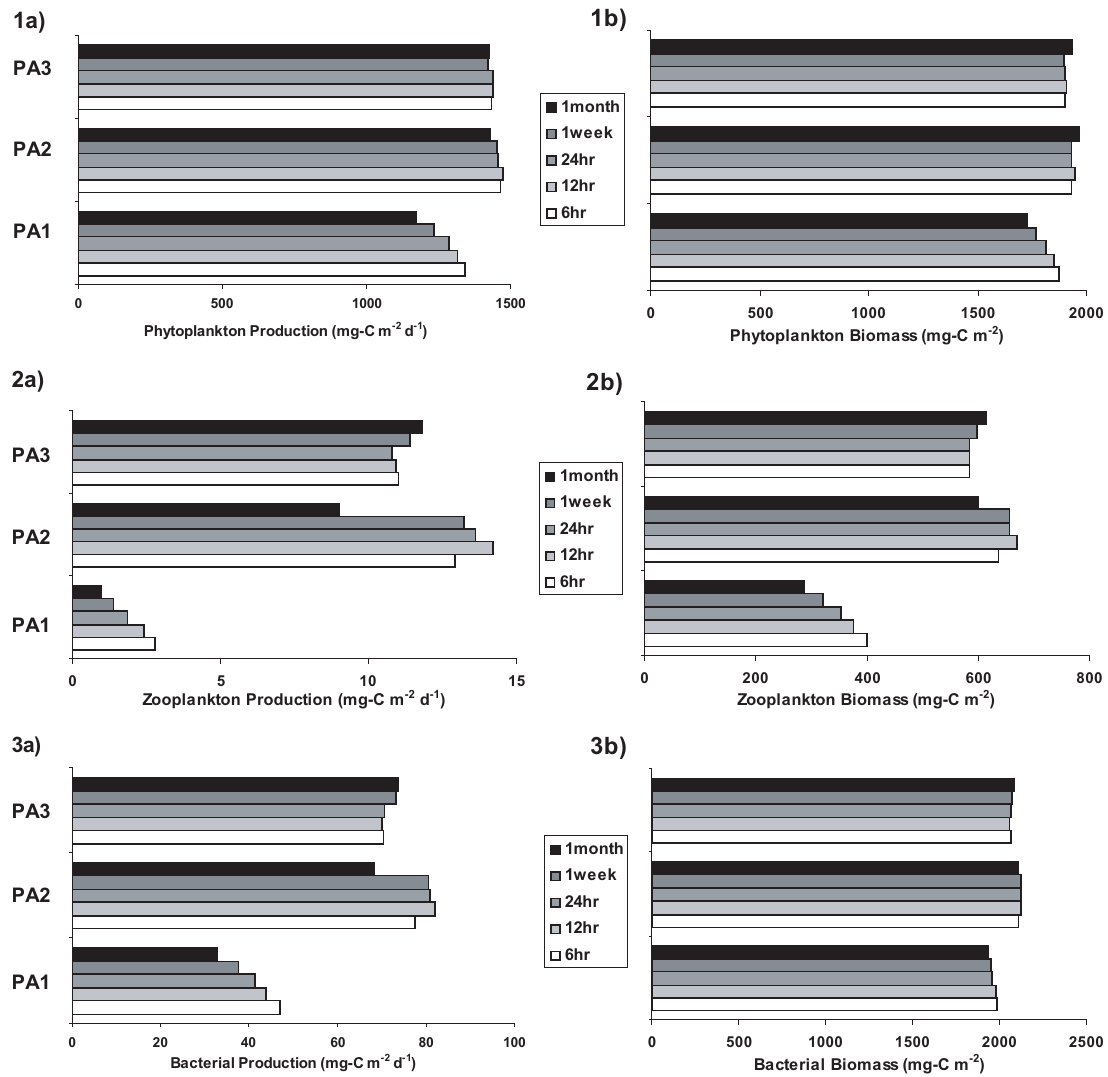
Fig. 9. Comparison of the annually averaged (a) production and (b) biomass for (1) phytoplankton, (2) zooplankton and (3) bacteria for PA1, PA2 and PA3 runs using different forcing